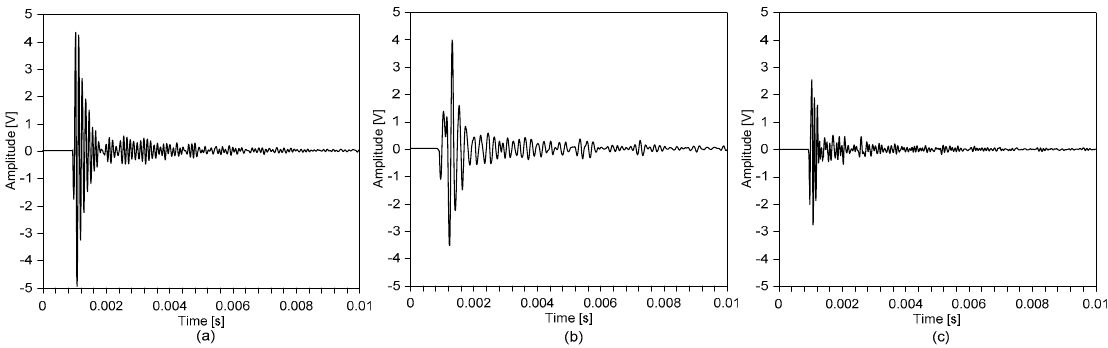
Figure 10. Typical time signals measured on the reinforced concrete slab specimen before and after the standard fire testing: ( a ) on the top surface of sound concrete, and on the bottom (fire-surface) ( b ) and top ( c ) surfaces of the fire-damaged concrete, respectively.